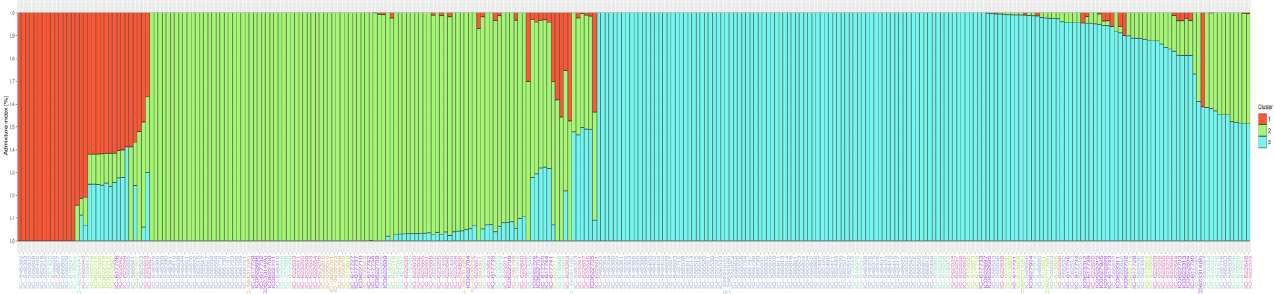
Figure 6. fastSTRUCTURE bar plot showing the number of population (K = 3) of 298 rice landraces using SNP markers.